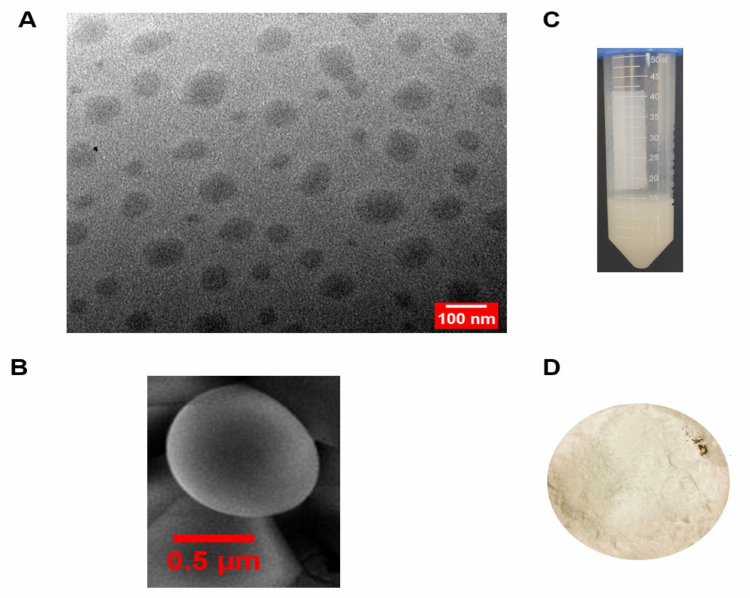
Figure 2. Typical macro- and microscopic imagery of the optimized CBD-loaded transfersome formulation (T6). ( A ) TEM image (scale bar 100 nm); ( B ) SEM image; ( C ) physical appearance of the transfersomes (T6); ( D ) lyophilized free-flowing powder of the transferomes